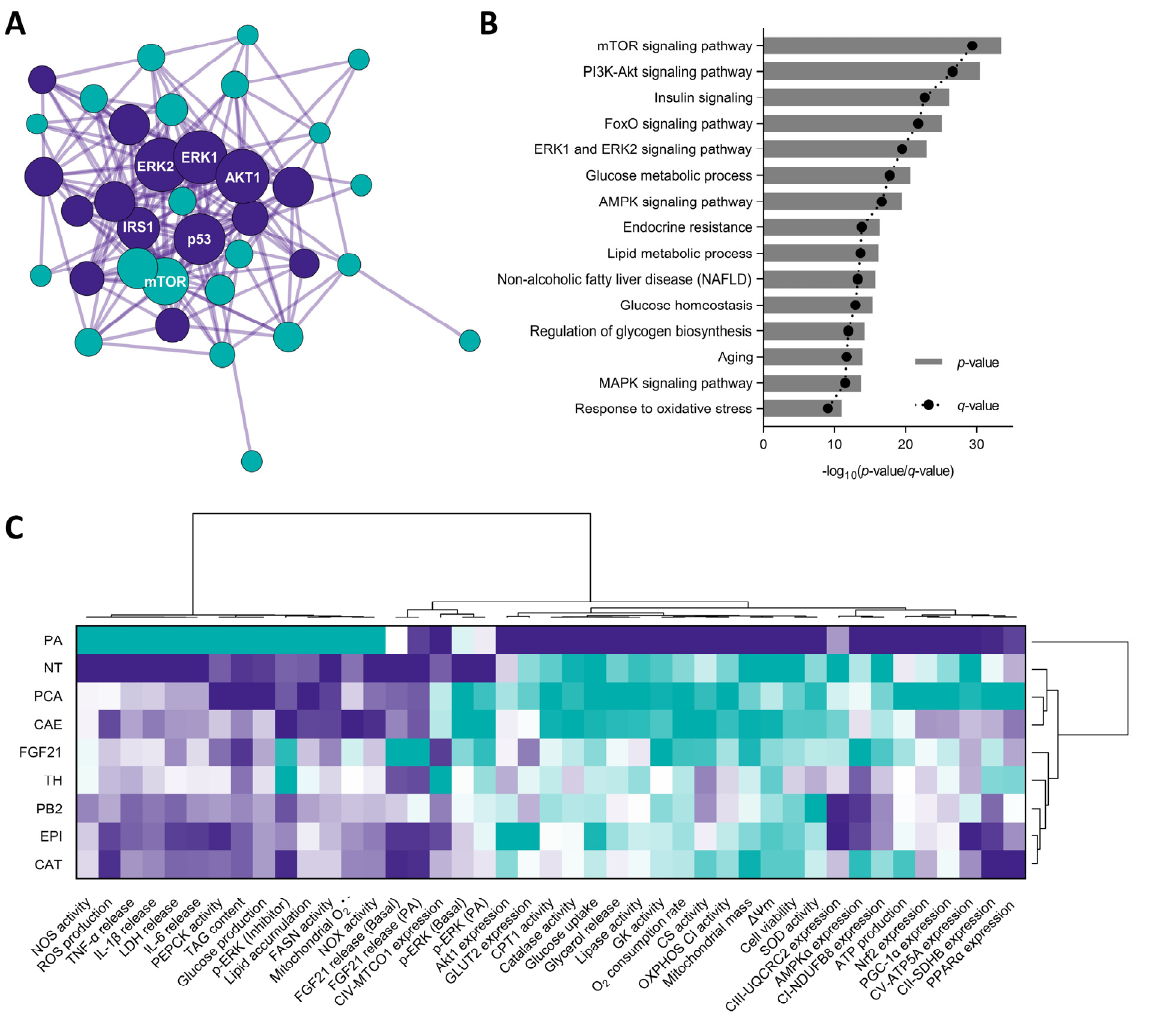
Figure 4. Protective effects of pure phytochemicals from the cocoa shell (50 µmol L − 1 ), aqueous ex- tract (CAE, 100 µg mL − 1 ), and FGF21 (20 nmol L − 1 ), in the presence of palmitic acid (PA, 500 µmol L − 1 ) against oxidative stress in HepG2 human hepatocytes. Phytochemicals from the cocoa shell re- duced the production of reactive oxygen species (ROS) ( A ) and mitochondrial O 2• − ( B ) while main- taining the mitochondrial membrane potential ( Δ Ψ m) ( C ) in PA-treated hepatocytes. The enzymatic activity of NADPH oxidase (NOX) ( D ), superoxide dismutase (SOD) ( E ), and catalase ( F ) were reg- ulated, thereby diminishing oxidative stress via the activation of the Nrf2 pathway by stimulating its protein expression and phosphorylation ( G ). Hierarchical cluster analysis and heat map (from the lowest ( ) to the highest ( ) value for each parameter) ( H ) and an integrative diagram illustrat- ing the effects of the phytochemicals from the cocoa shell on oxidative stress ( I ). The results are expressed as mean ± SD ( n = 3). Bars with different letters (a–f) significantly ( p < 0.05) differ accord- ing to ANOVA and Tukey’s test. NT: non-treated cells; TH: theobromine; PCA: protocatechuic acid; PB2: procyanidin B2; EPI: epicatechin; CAT: catechin; FGF21: fibroblast growth factor 21.